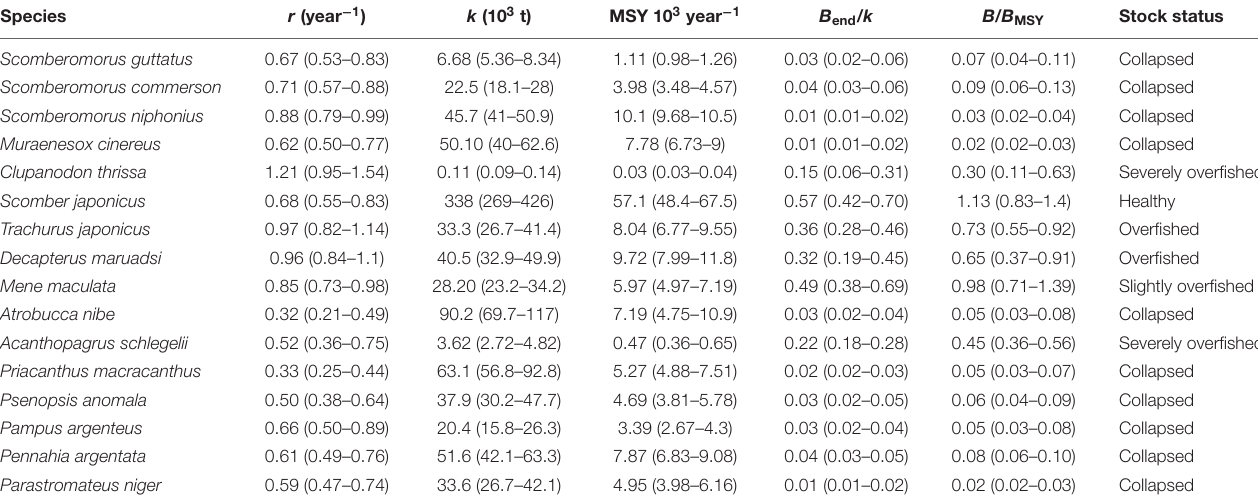
TABLE 3 | Fisheries reference points ( r , k , and MSY), relevant biomass ( B end / k and B / B MSY ) and stock status of 16 commercially exploited stocks estimated from BSM method. Species